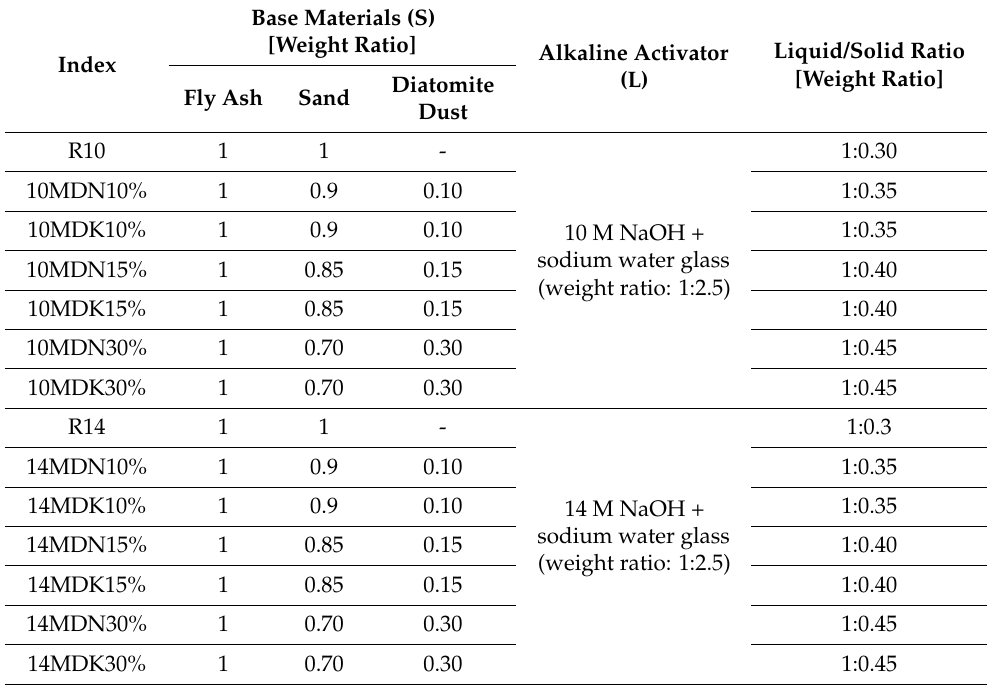
Table 2. Composition of geopolymer samples based on fly ash from Belchatow, sand, and diatomite dust (non-calcined (DN) and calcined (DK)).